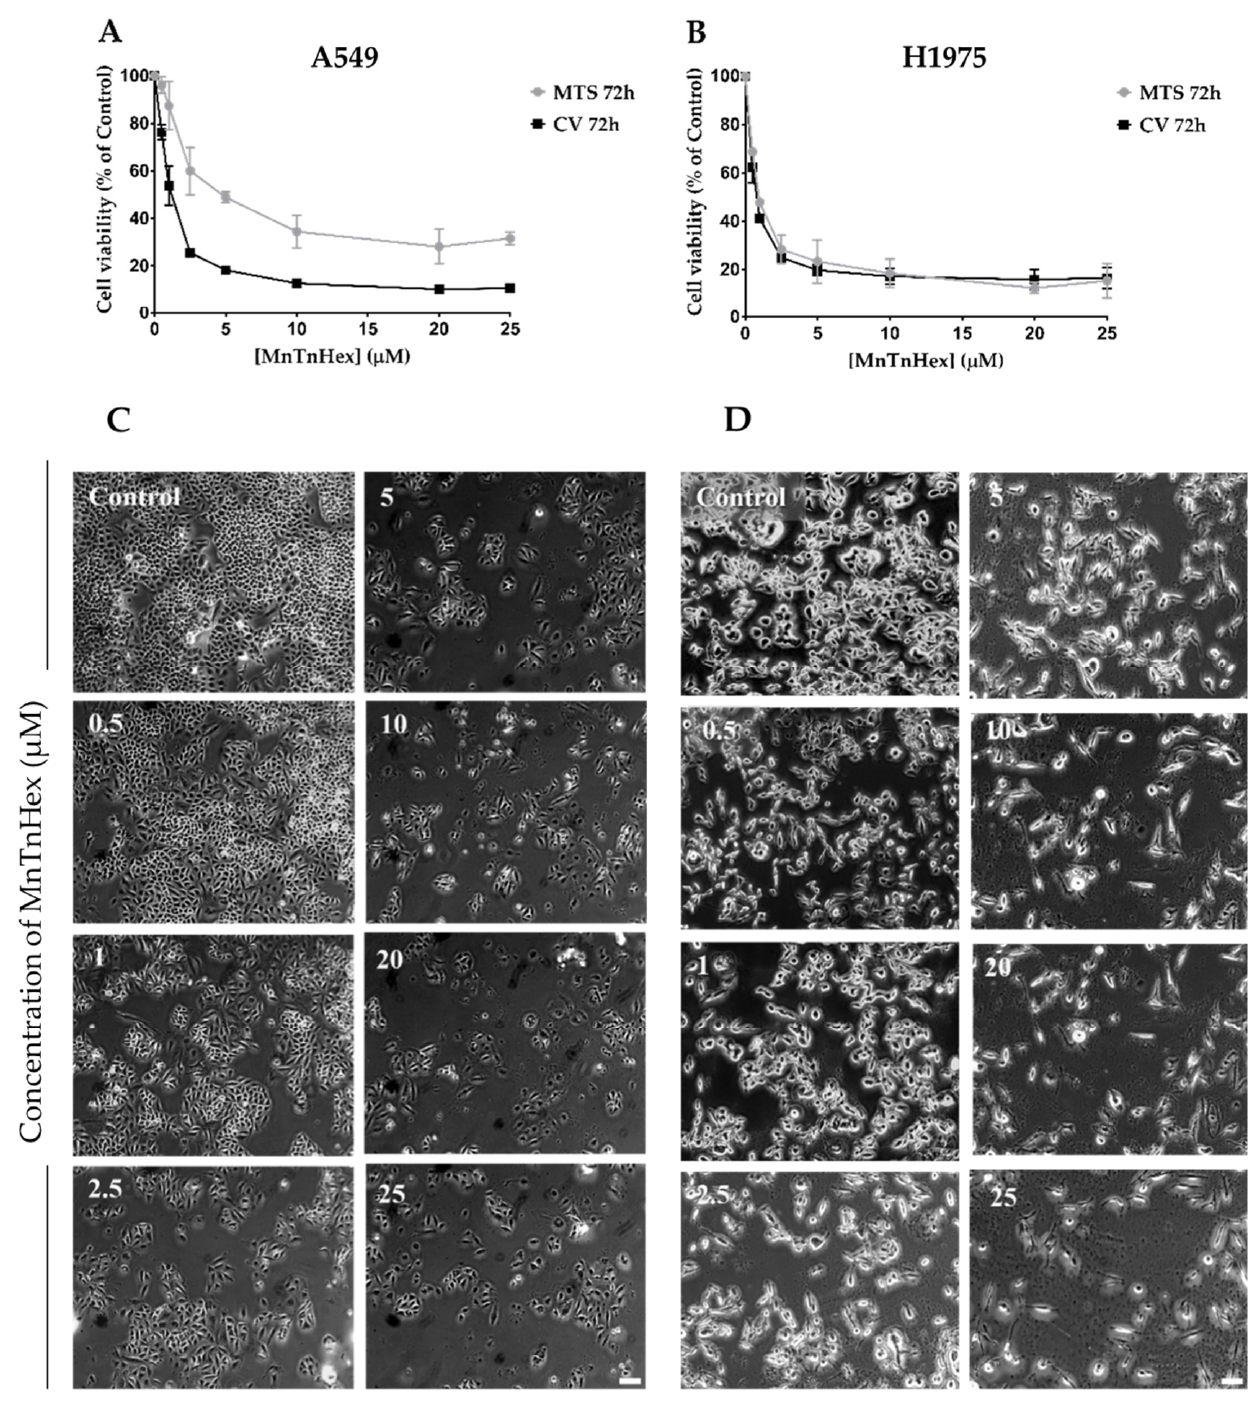
Figure 3. Cytotoxic effects of MnTnHex (0.5–25 μ M) in A549 and H1975 cells. The decrease in cell viability upon exposure to MnTnHex, for 72 h, was assessed by CV and MTS assays in ( A ) A549 and ( B ) H1975 cells. Values represent mean ± SD ( n = 3–4) and are expressed as percentages of the vehicle-treated control cells. ( C ) A549 cell morphology upon treatment with MnTnHex. ( D ) H1975 cell morphology upon treatment with MnTnHex. Scale bar = 100 μ m.